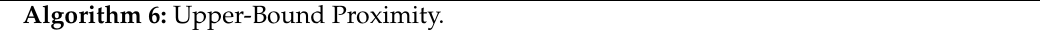
Figure 12. Search space difference. Algorithm 6: Upper-Bound